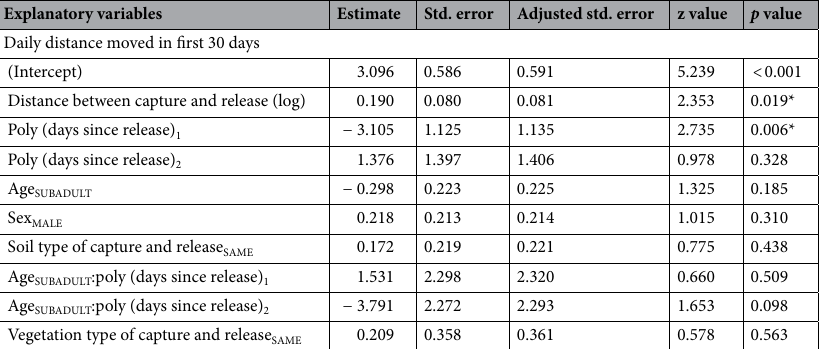
Table 1. Summary output from model averaging the top (∆AIC ≤ 2) generalised linear mixed models showing relationships (conditional average) with daily distance moved by koalas in the 30 days after release. Significant relationships are identified by asterisks. The categorical reference groups are: adult for age, female for sex, different for soil type of capture and release, and different for vegetation type of capture and release.